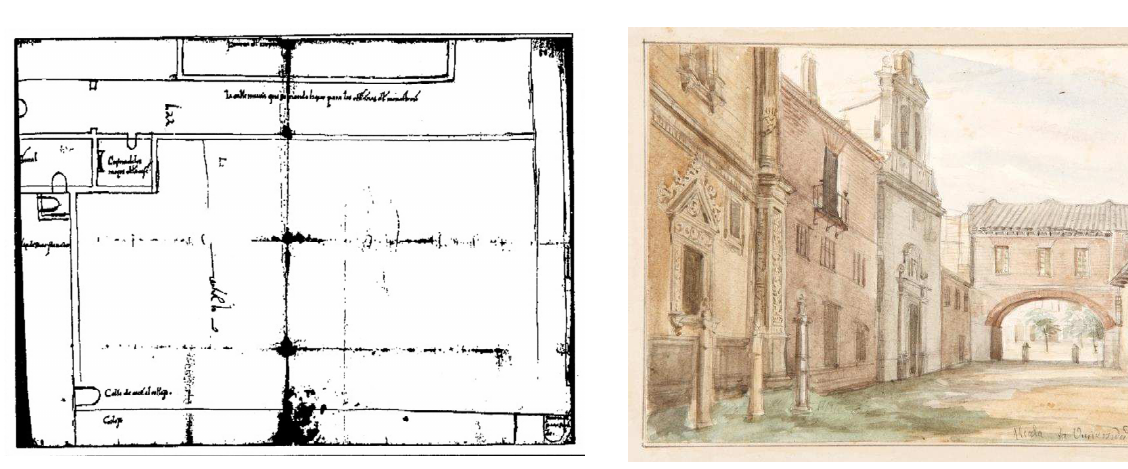
Figure 5: Sketch of Pedro de Gumiel. 1511 (AHN)